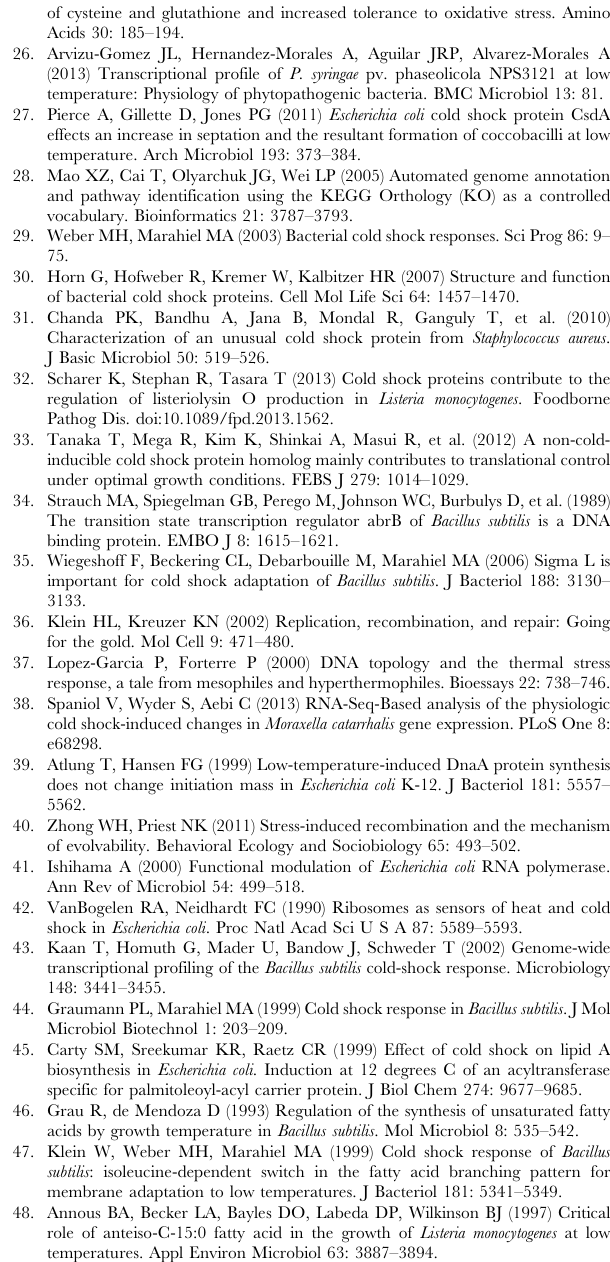
Table S1 Primers used for real-time PCR. Table S2 Differentially expressed genes according to DESeq analysis. Table S3 Twenty most highly transcribed genes in TTECS and TTE75.